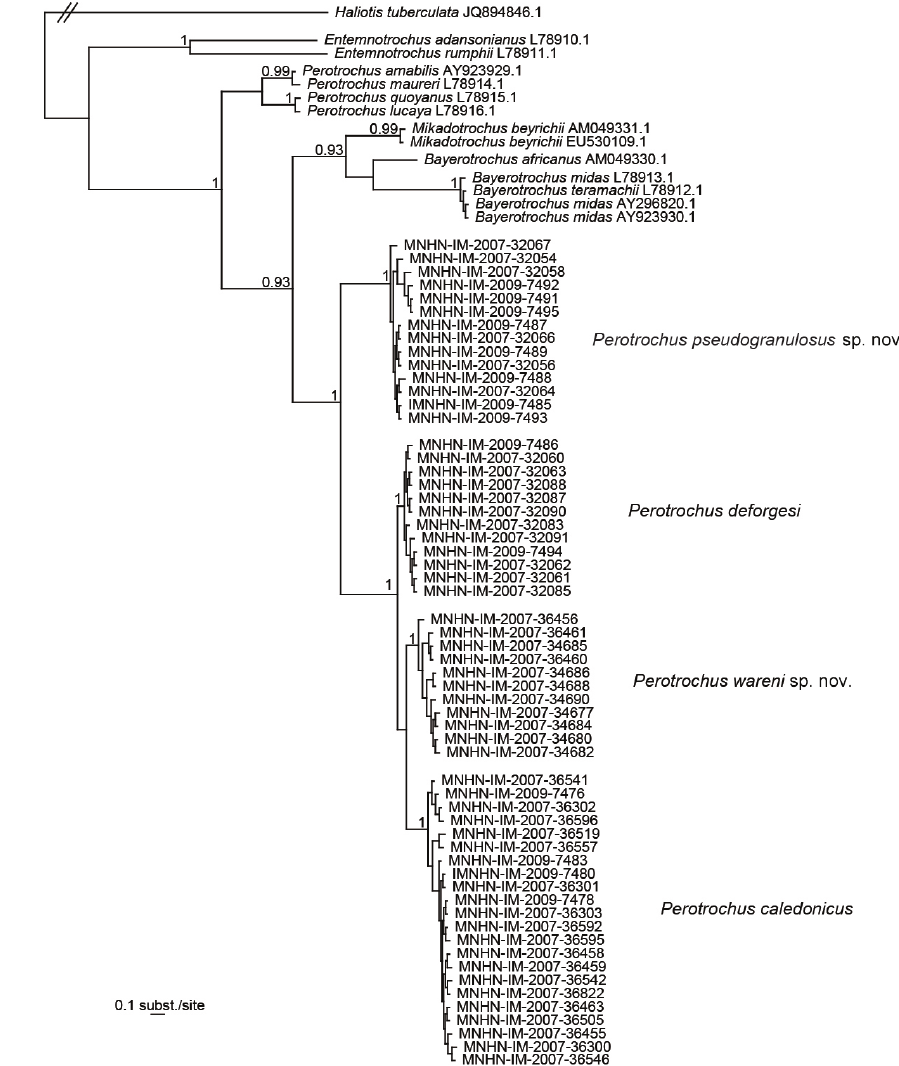
Fig. 2. Bayesian phylogenetic tree. Posterior probabilities (> 0.90) are shown for each